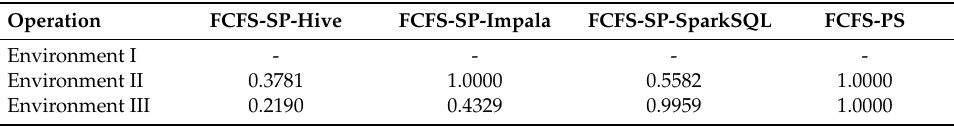
Table 14. Normalized performance index for Case 2.